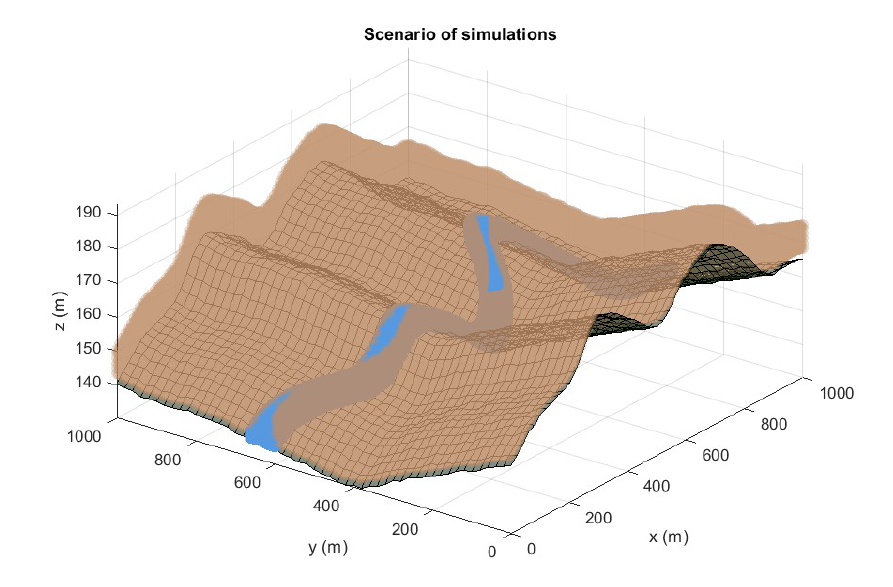
Figure 1. The scenario of simulations. Grey colors indicate the reference surface, blue colors represent the Target Location Environment (TLE) region, and brown zones show the Node Location Environment (NLE)